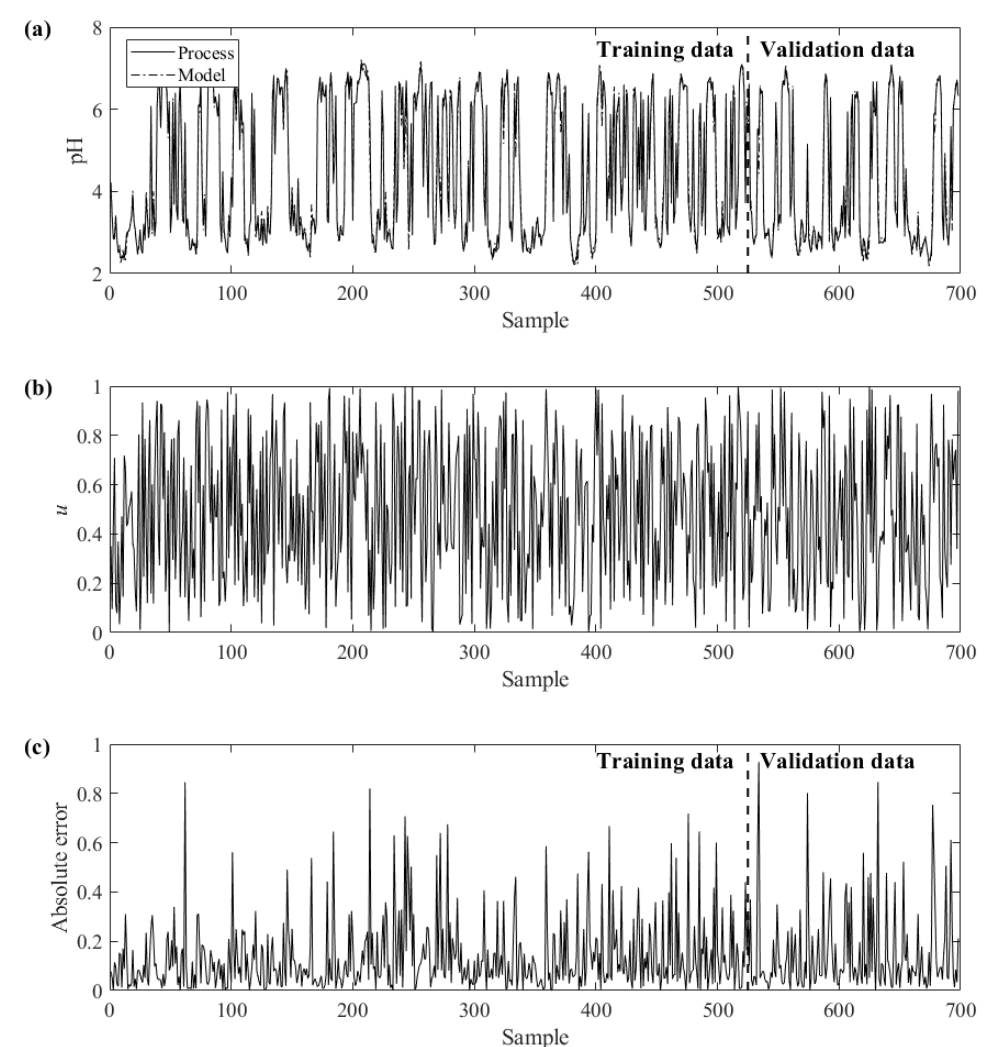
Figure 3. Process data and performance: ( a ) process output and model output obtained from neural network with 7 hidden nodes, ( b ) process input, and ( c ) absolute error between measured and predicted